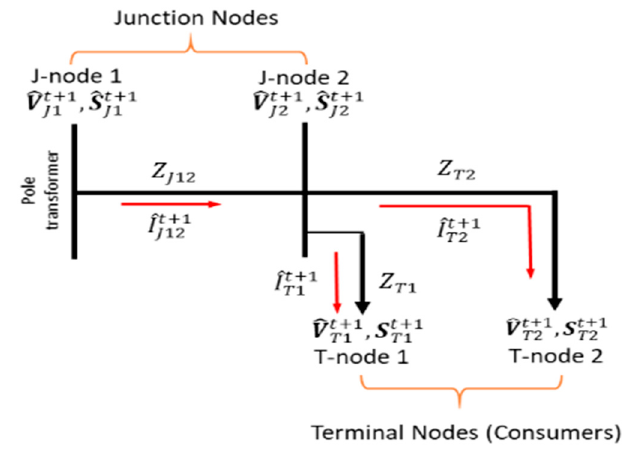
Figure 6. Simplified Linear Low-Voltage Distribution network topology.